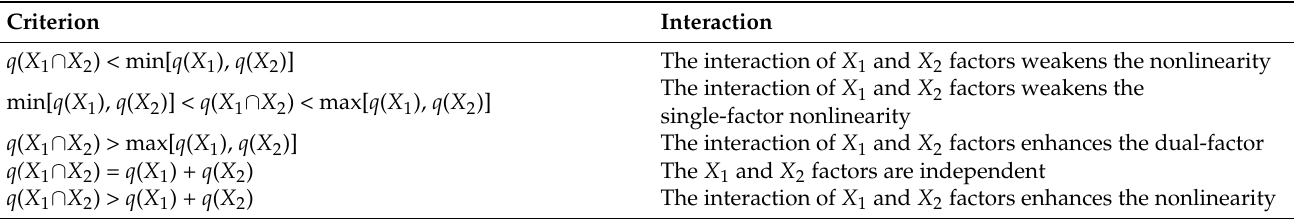
Table 2. Interaction types of Geodetector